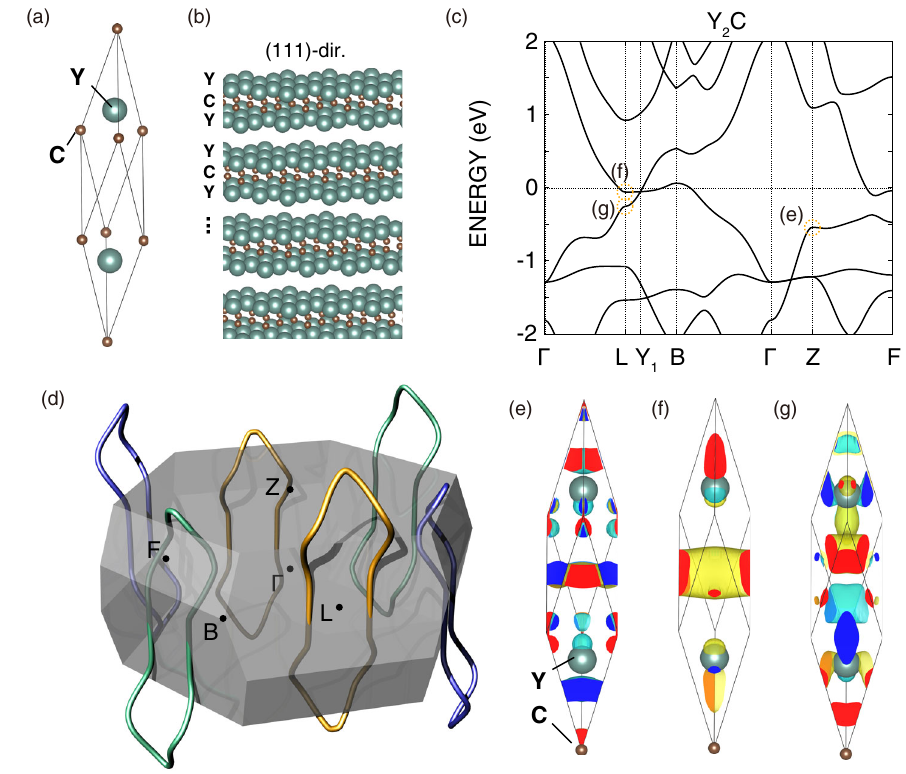
FIG. 1. Topological nodal line in Y 2 C. (a) Crystal structure of Y 2 C and Sc 2 C. The blue and brown balls represent Y/Sc and C atoms, respectively. (b) Layered crystal structure along (111) in Y 2 C and Sc 2 C. (c) Electronic band structure of Y 2 C in the generalized gradient approximation (GGA). The energy is measured from the Fermi level. (d) Nodal lines and the Brillouin zone of Y 2 C, where identical nodal lines (modulo the reciprocal vectors) are shown in the same color. In (e), (f), and (g), we show wave functions of some of the eigenstates, where the colors indicate the amplitudes of the wave functions themselves. The yellow and light blue represent the positive and negative components of the wave function, respectively, and the red and navy blue represent their cross sections, respectively. (e) Eigenstate of the top of the valence band at the Z point. (f),(g) Eigenstates at − 0 . 062 and at − 0 . 256 eV at the L point, respectively. These eigenstates are marked in the band structure in